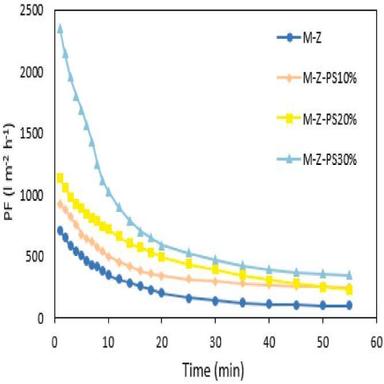
Flux over filtration time of the oily wastewater on M-Z, M-Z-PS10, M-Z-PS20 and M-Z-PS30 membrane.